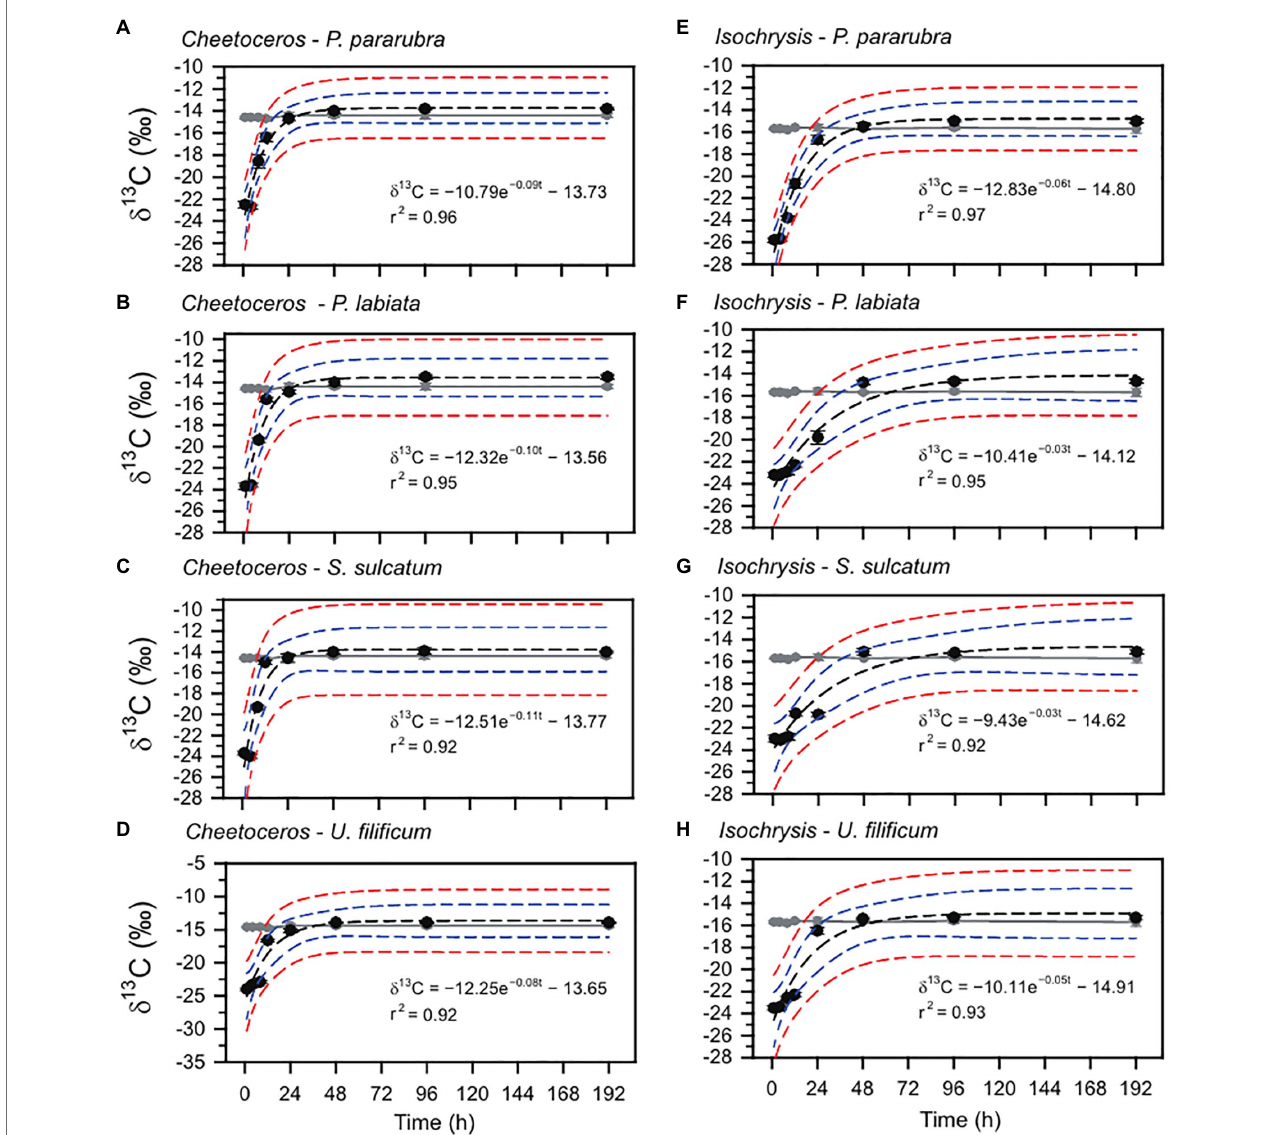
FIGURE 2 | Carbon stable isotope variation and exponential model for P. pararubra , Protocruzia labiate , Strombidium sulcatum , and Uronemella filificum fed with Chaetoceros calcitrans (Chaeto) and Isochrysis galbana (Isochrysis). Black and gray circles are the mean of carbon stable isotope values ( δ 13 C) for ciliates and foods, respectively. Vertical lines are ± SD . Black and blue dashed lines indicate the fitting curve and 95% confidence,